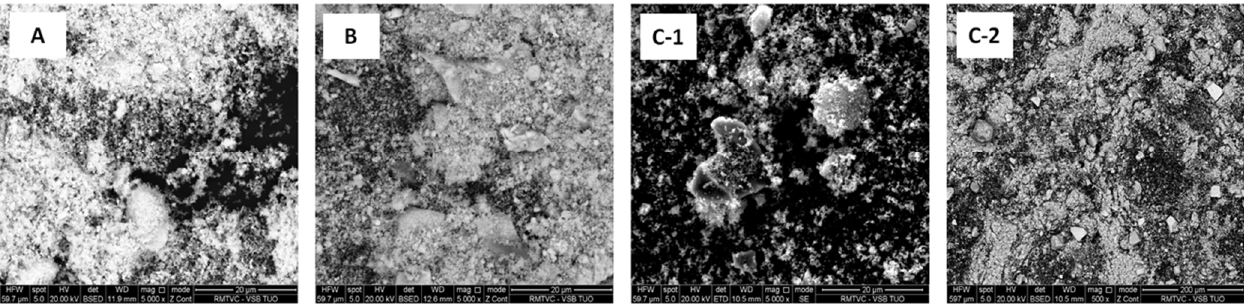
Figure 5. Form and color of the untreated waste Fe sludge (WFS), waste Fe sludge washed in water (WFS/0), waste Fe sludge calcined at 180 °C (WFS/180), and waste Fe sludge calcined at 900 °C (WFS/900). Figure 5 show untreated (labeled as WFS) and treated pigments (labeled as WFS/0, WFS/180, and WFS/900). Washing the waste with water removes soluble impurities. Washing and calcination lead to a partial reduction of the Zn and Cl amount contained in the sludge. After calcination, the amount of H 2 O decreased. WFS/180 and WFS/900 con- tained 2.2 wt.% and 0.2 wt.% of H 2 O, respectively. Density of WFS/0, WFS/180, and WFS/900 was 3.85 g/cm 3 , 4.95 g/cm 3 , and 4.46 g/cm 3 , respectively. During calcination of WFS/180, iron oxyhydroxides dehydrated to Fe 2 O 3 . This sludge must be well washed to remove most of the ZnCl 2 contained in the sludge. As mentioned before, the higher the calcination temperature, the more significant dehydration occurred. By calcination at 900 °C, the washed sludge was stabilized. The prepared pigments WFS/180 and WFS/900 are very fine powders. This is proven by their specific surface area (SSA) and better absorption of loose moisture compared to the WFS/0 sample, which was slightly coarser. Cl − bound in the structure and α -FeOOH were re- leased during heat treatments as HCl. At the same time, the amount of Zn is reduced by up to 97%. During calcination of the WFS/900 sample, the Cl − in the mixture was signifi- cantly eliminated (by almost 99%). While the original waste Fe sludge WFS/0 contained ~41 wt.% of Fe 2 O 3 , usable waste sludge containing up to 90 wt.% of α -Fe 2 O 3 was obtained by the calcination.